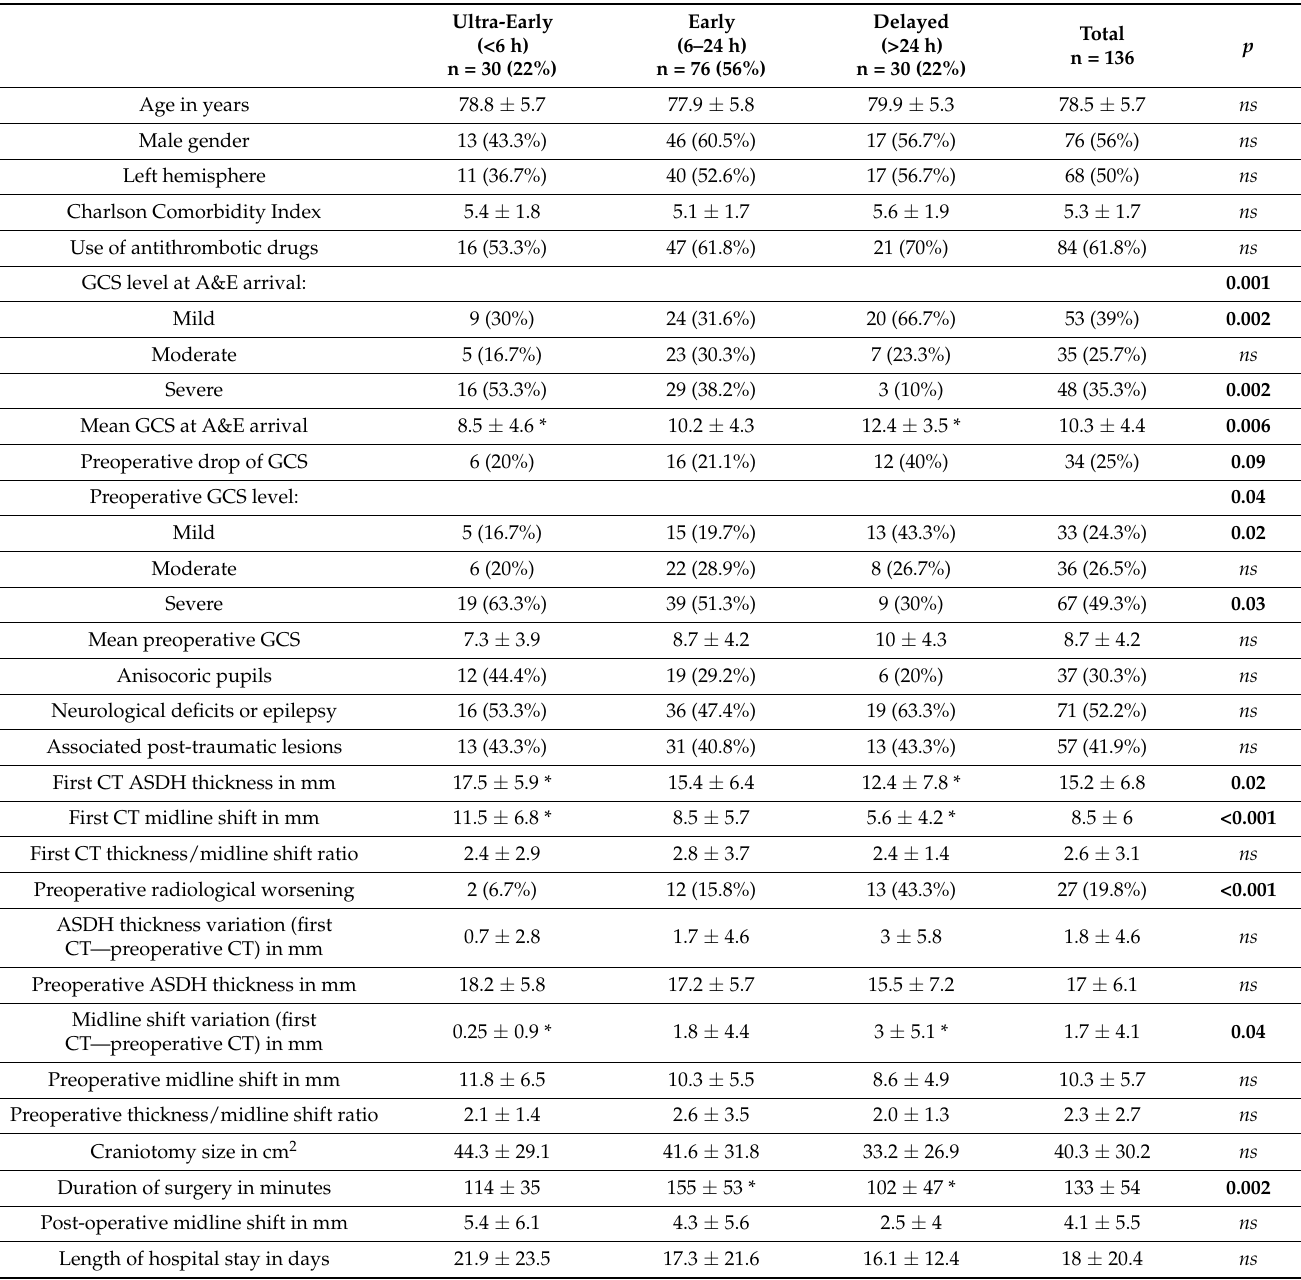
Table 1. Demographical, radiological and clinical